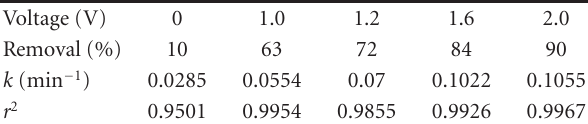
Table 1: Cu 2+ removal, the reaction rate constant k and correlation coe ffi cients r 2 of kinetic equation at di ff erent applied